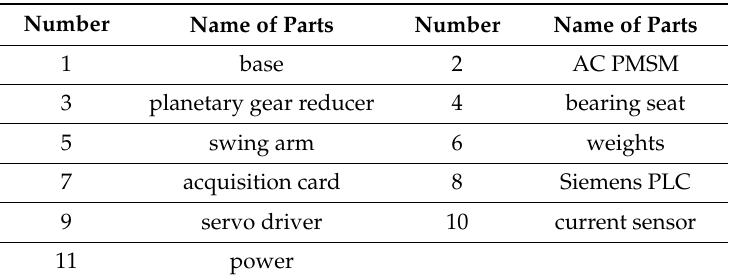
Table 1. Description of the parts of the test stand.